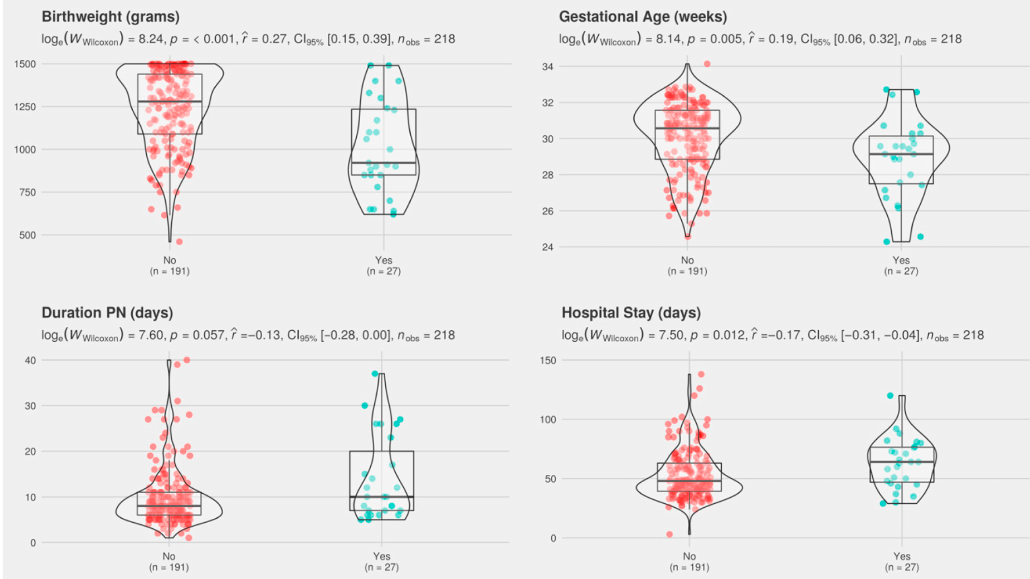
Figure 2. Boxplot merged with a violin plot (a rotated kernel density plot on either side) comparing gestational age, birth weight, hospital stay, and duration of parenteral nutrition (PN) in patients with metabolic bone disease (MBD, cases) versus controls. ‘Yes’ indicates MBD cases and ‘No’ indicates non-MBD patients. In box plots, the boundary of the box closest to zero represents the 25th percentile, the line within the box represents the median, and the boundary farthest from zero represents the 75th percentile. Lines above and below the box represent the 10th and 90th percentiles, respectively. Red and green dots represent the variable in question for cases and controls, respectively. Corresponding mean and interquartile ranges for each variable are provided in Table 2. Violin plots represent kernel density estimation and depict the distribution shape of the data; the probability that infants of the population will take on the given value is higher in wider areas and lower in narrower